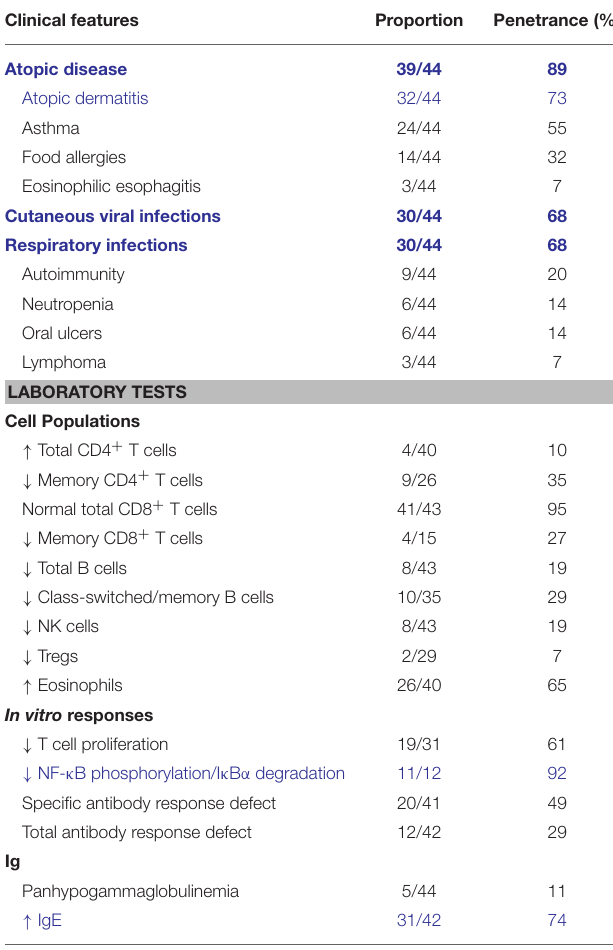
TABLE 4 | “Red flags” suggestive of CADINS disease (DN LOF CARD11 mutations). Clinical